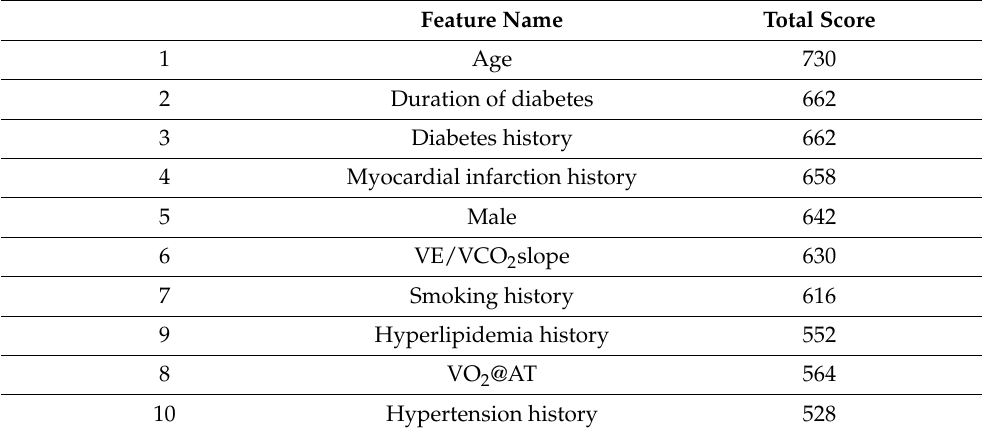
Table 3. Importance ranking of top 10 clinical features included in machine learning.